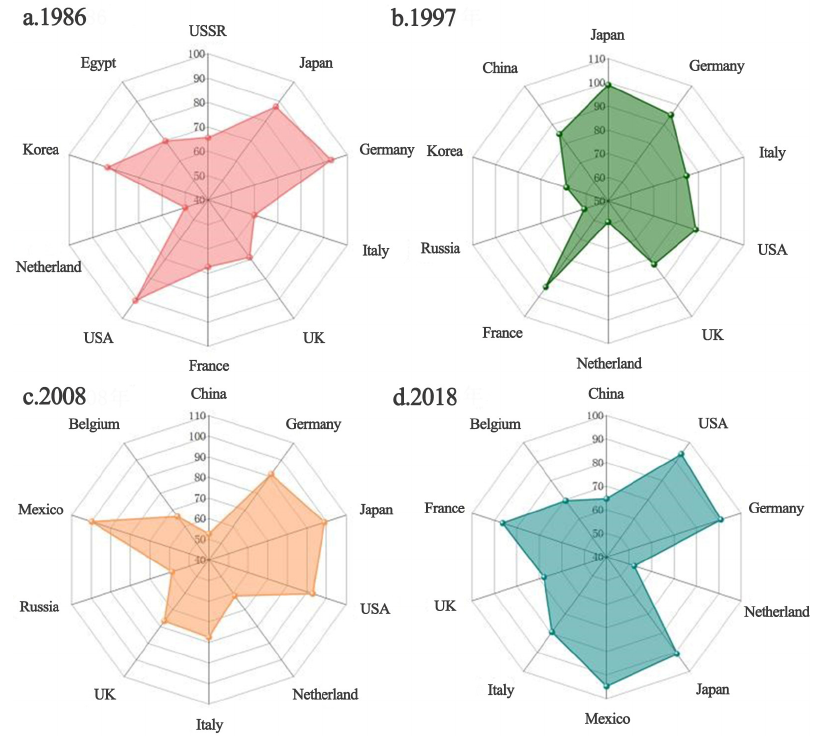
Figure 2. Satisfaction level of global agricultural trade network community in ( a ) 1986, ( b ) 1997, ( c ) 2008, and ( d ) 2018.